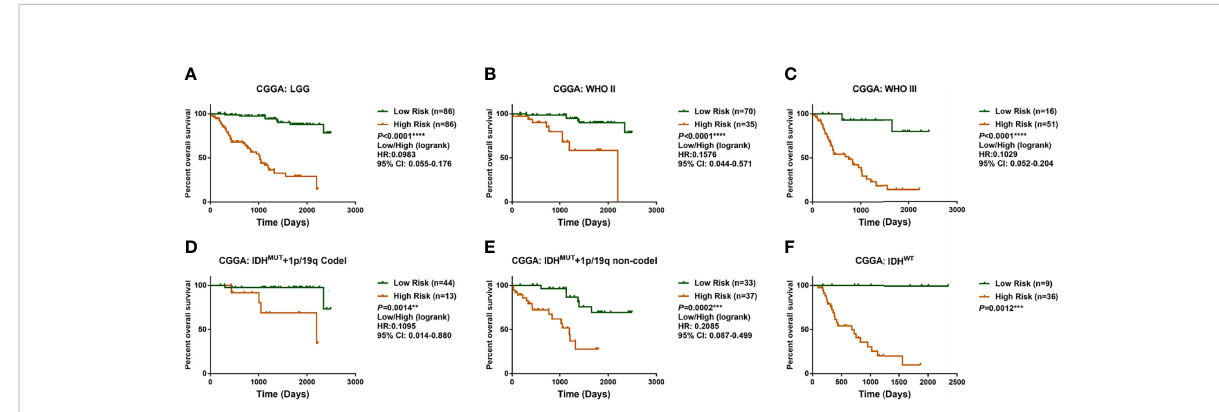
FIGURE 3 Identi fi cation and validation of prognostic signi fi cance for the enzyme-based risk signature. (A) LGG patients with high-risk scores survived shorter than the low-risk patients in CGGA cohort. The enzyme-based risk signature could be used to stratify patients into two populations with distinct overall survival times regarding WHO grade (B, C) and LGG subgroups (D – F) . ** p < 0.01, *** p < 0.001 and **** p < 0.0001. LGG, lower- grade glioma; CGGA, Chinese Glioma Genome Atlas.